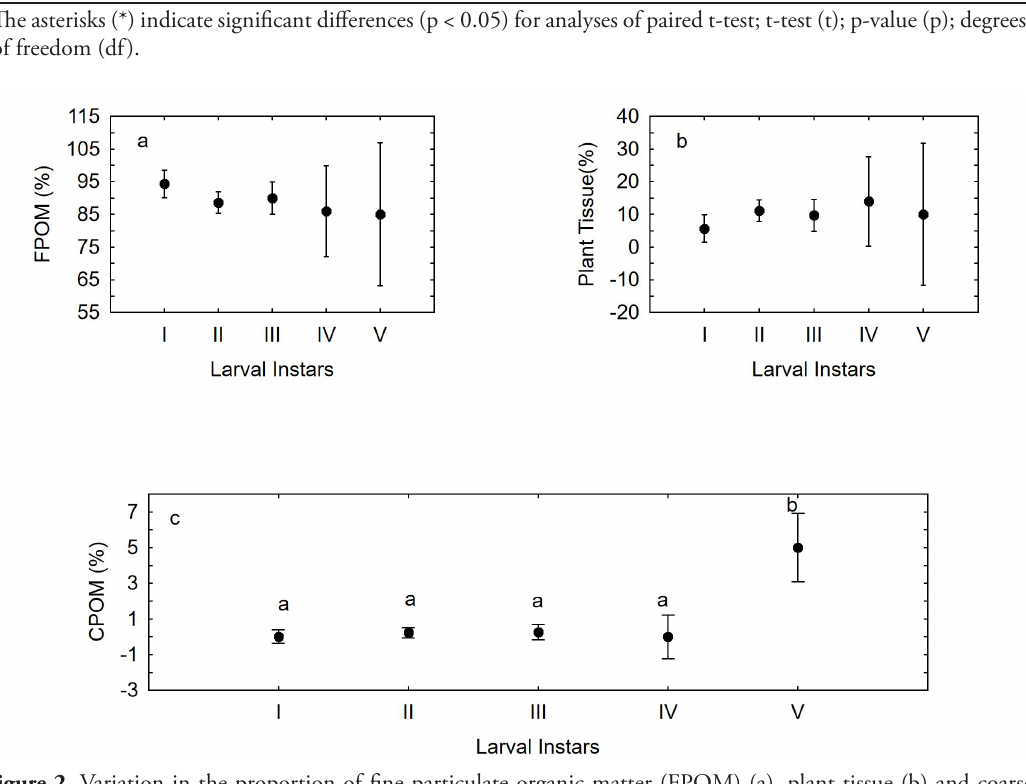
Figure 2. Variation in the proportion of fine particulate organic matter (FPOM) (a), plant tissue (b) and coarse particulate organic matter (CPOM) (c) ingested by the different larval instars of Phylloicus collected from forest streams in western Pará, Brazil .